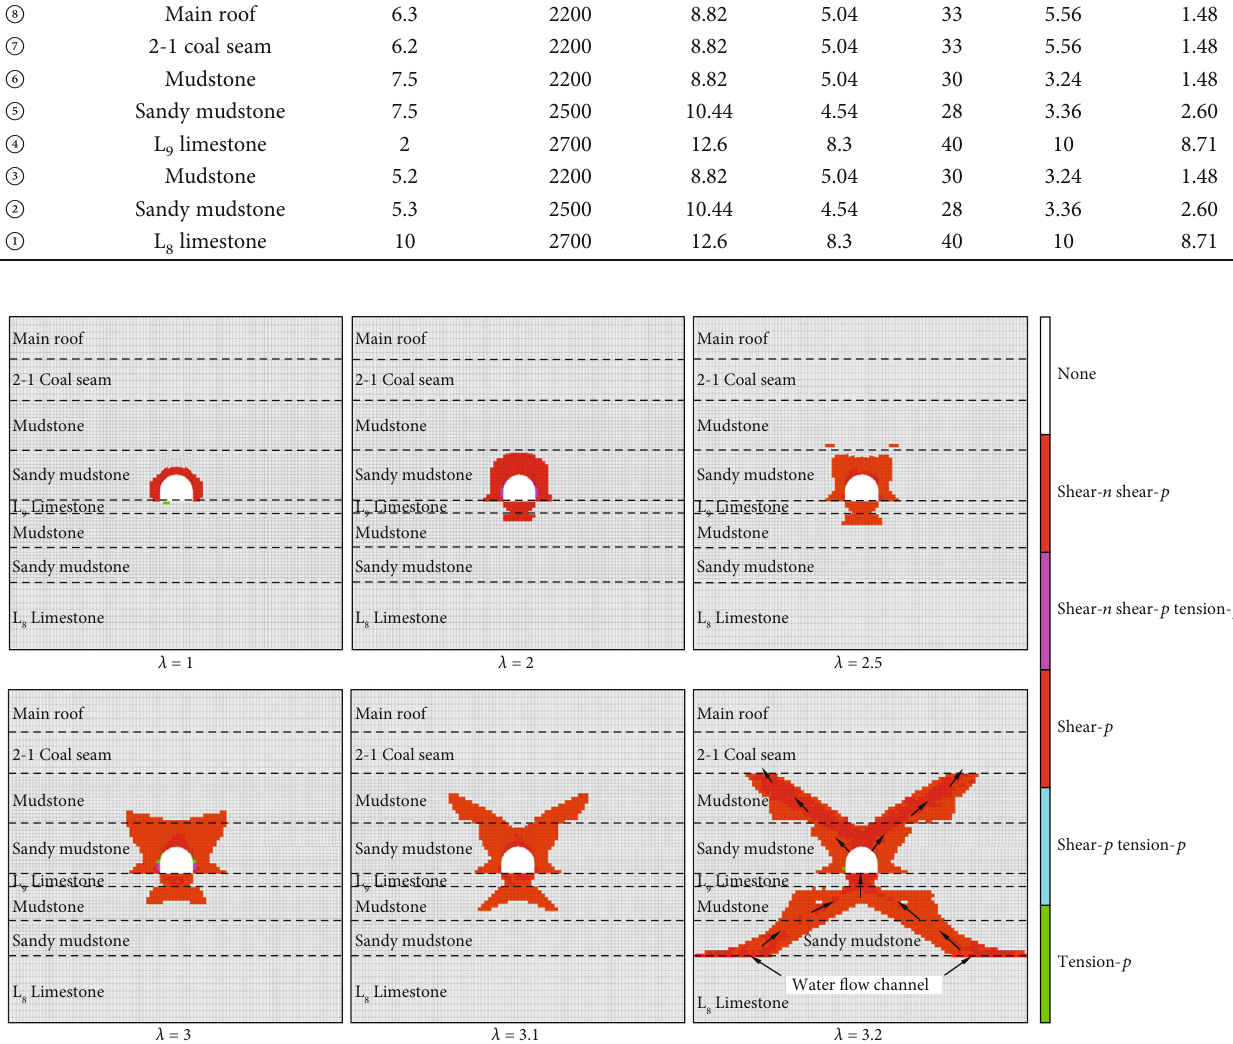
Figure 8: The numerical simulation result of butter fl y-shaped plastic